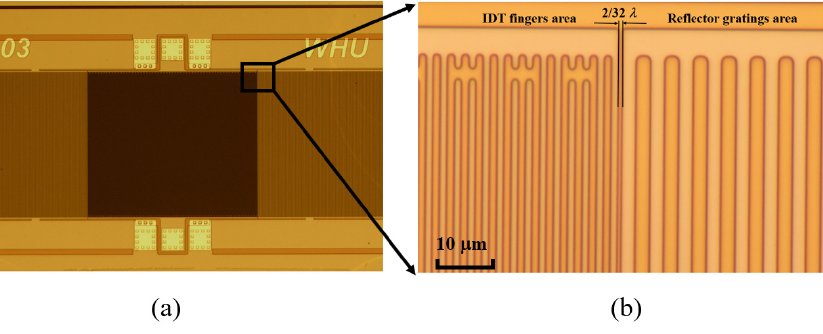
Figure 4. Optical microscope images of a fabricated QSAW resonator: ( a ) overall view of resonator, ( b ) zoom-in view of space between IDT fingers and reflector